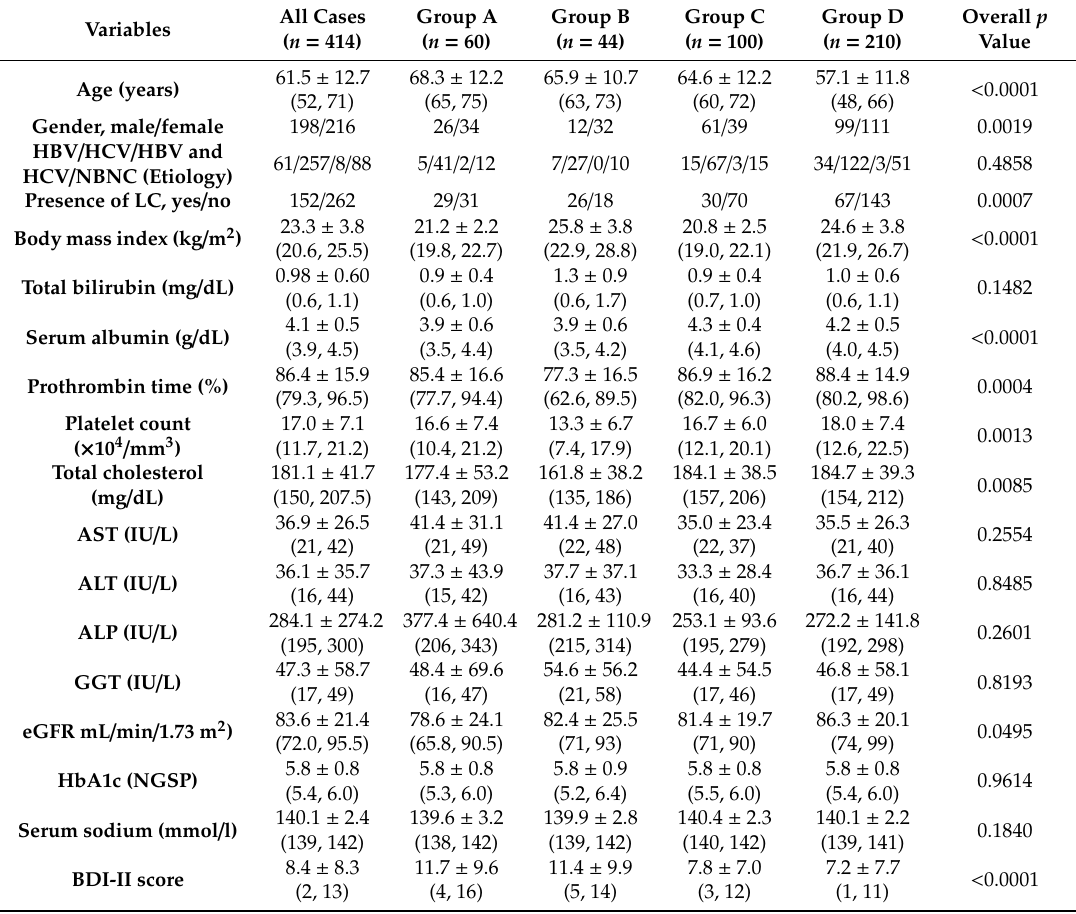
Table 2. Baseline